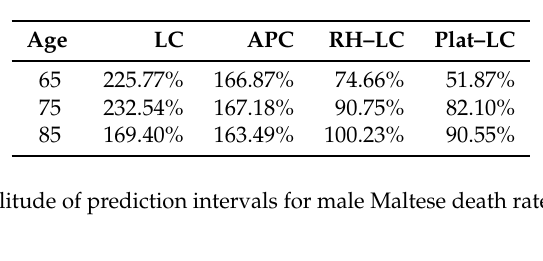
Table 11. Relative amplitude of prediction intervals for female Maltese death rates in 2046 with different mortality models.